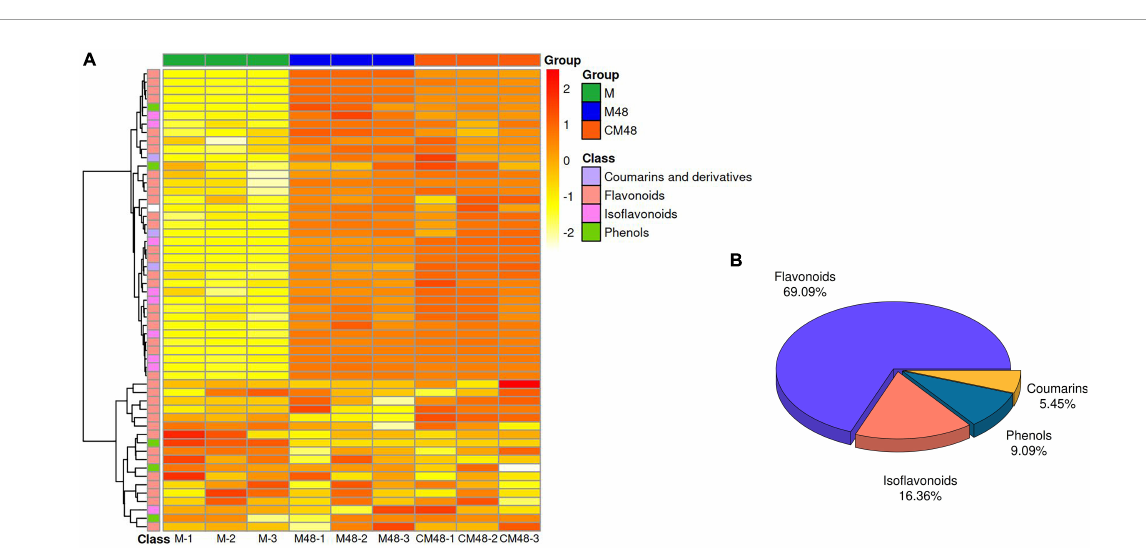
This indicates that the optimized conditions for enrichment of mung bean sprout with polyphenols using response surface analysis are